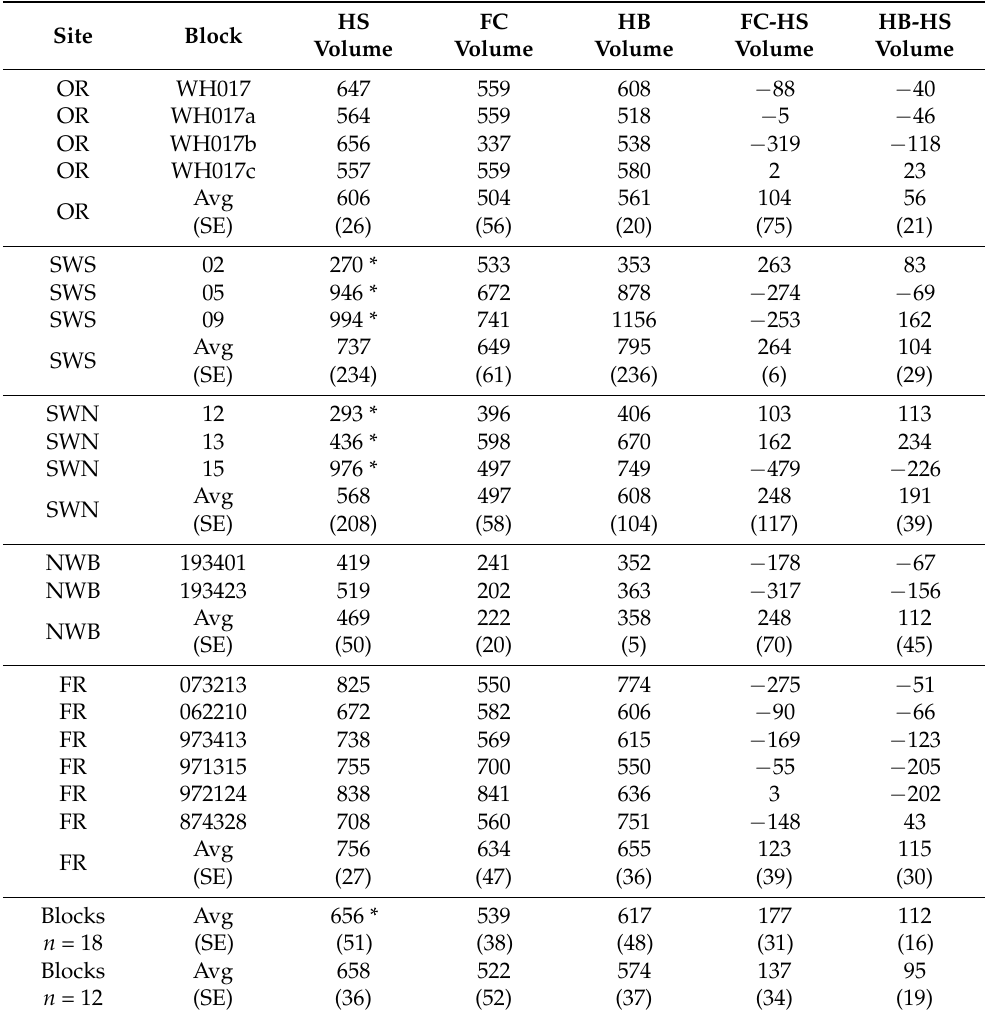
Table 5. Block merchantable volumes (m 3 ha − 1 ) for the post-harvest scale (HS), pre-harvest forest cover (FC), pre-harvest hybrid model (HB), and differences in pre-harvest estimates from post-harvest validation. Average differences use the absolute value of block differences. SE—standard error. * Note: HS values for SWS and SWN were simulated using field measurements for all trees in the block. All blocks n = 12 excludes HS values for SWS and